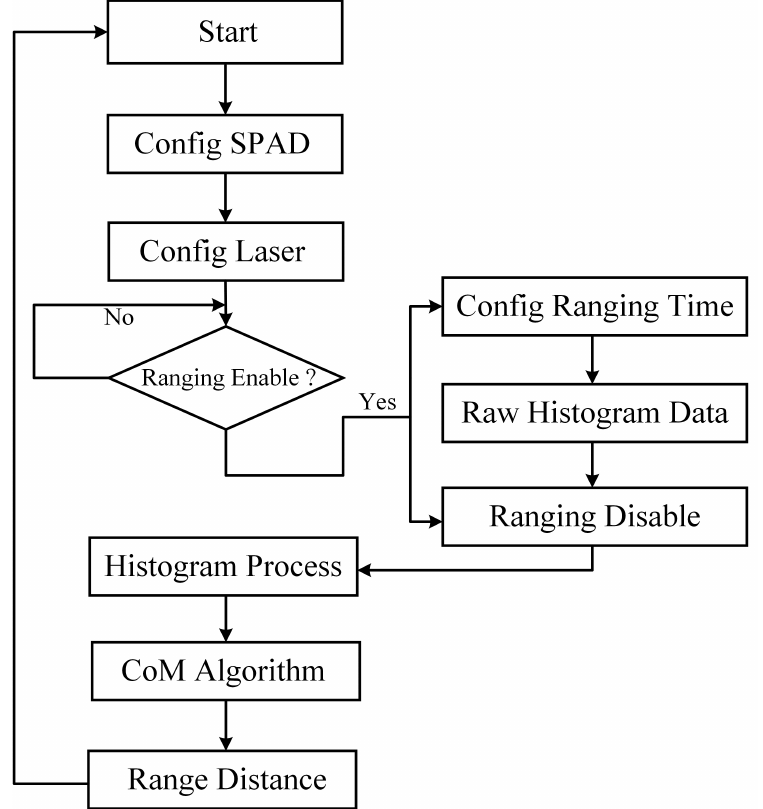
Figure 10. The best profile-matched filter implemented in the MCU core.